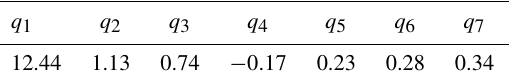
Table 4. IEA 15MW reference wind turbine blade: geometric di- mensions, mass, and initial curvature limits in the prebend ( y ) and twist directions.